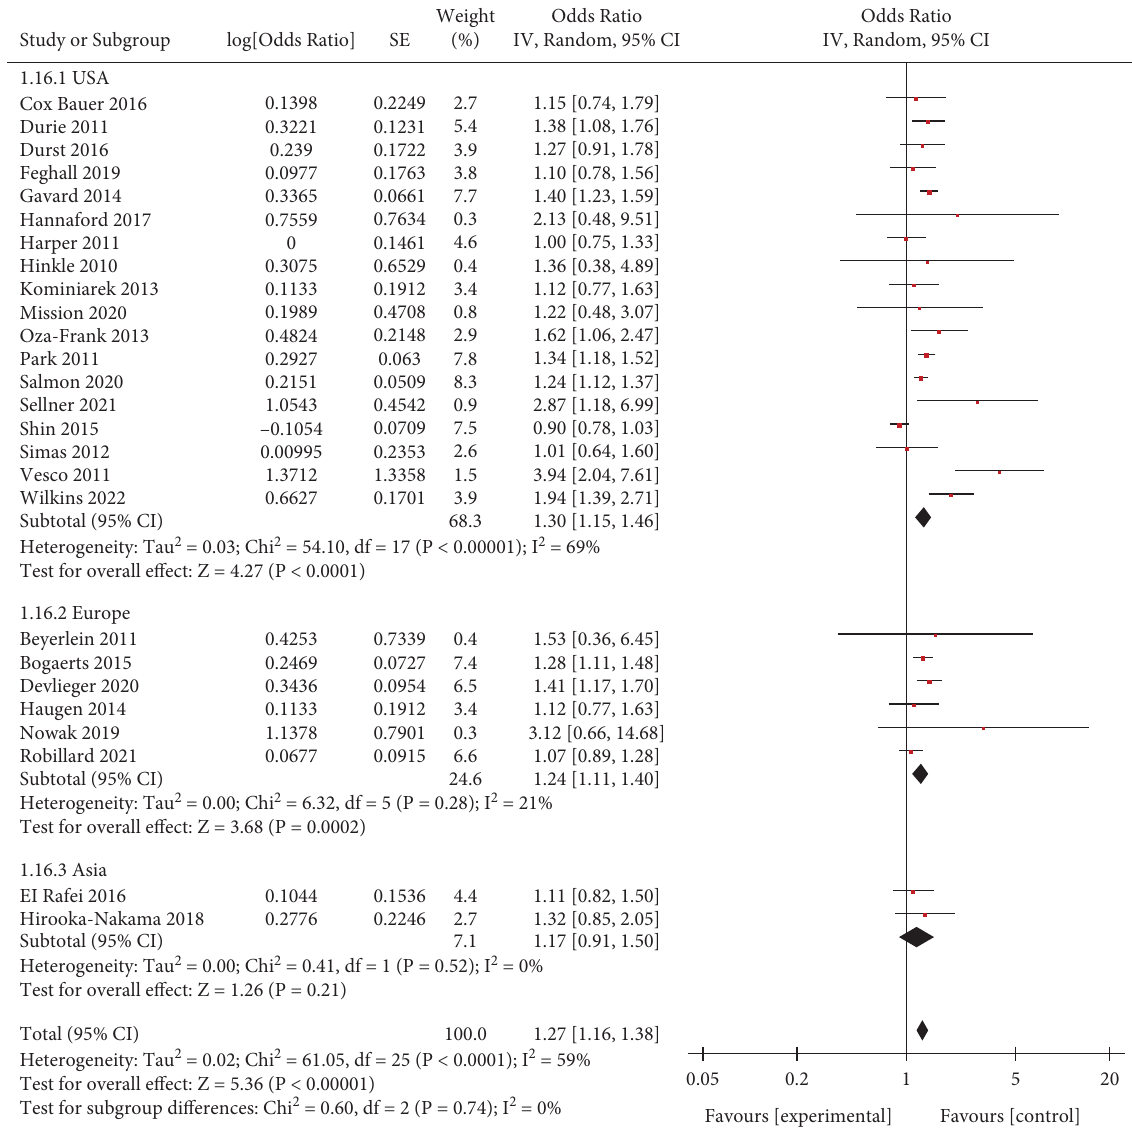
Figure 9: Forest plot of the association between weight gain below the guidelines in obese women of each country and SGA.